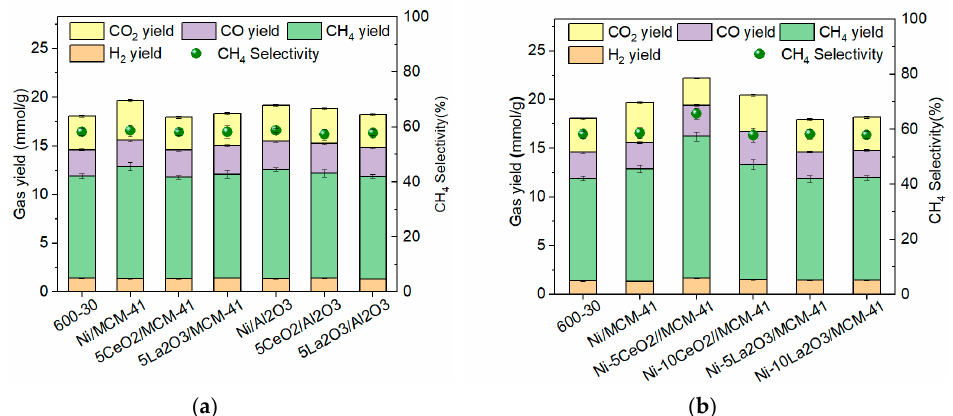
Figure 8. Gas yields over monometallic (a) and bimetallic catalysts (b).